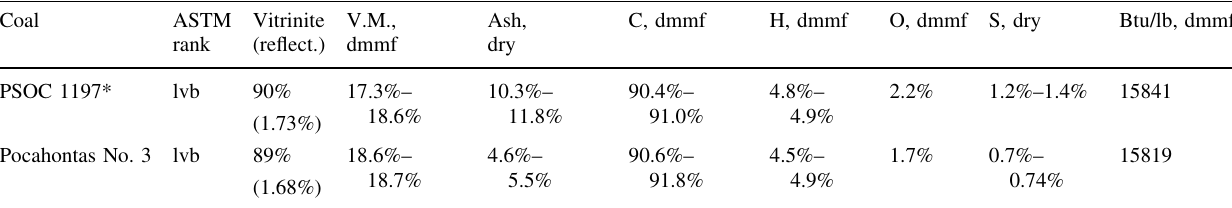
Table 1 Comparison of proximate and ultimate analyses of the coals Coal